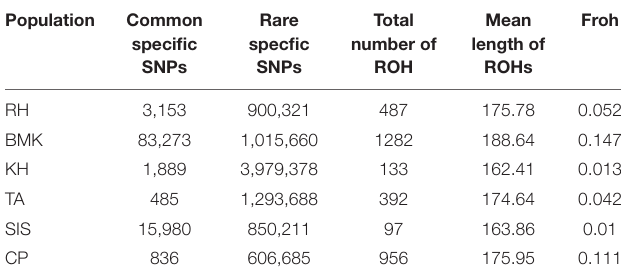
TABLE 2 | Genetic statistical summary of the six